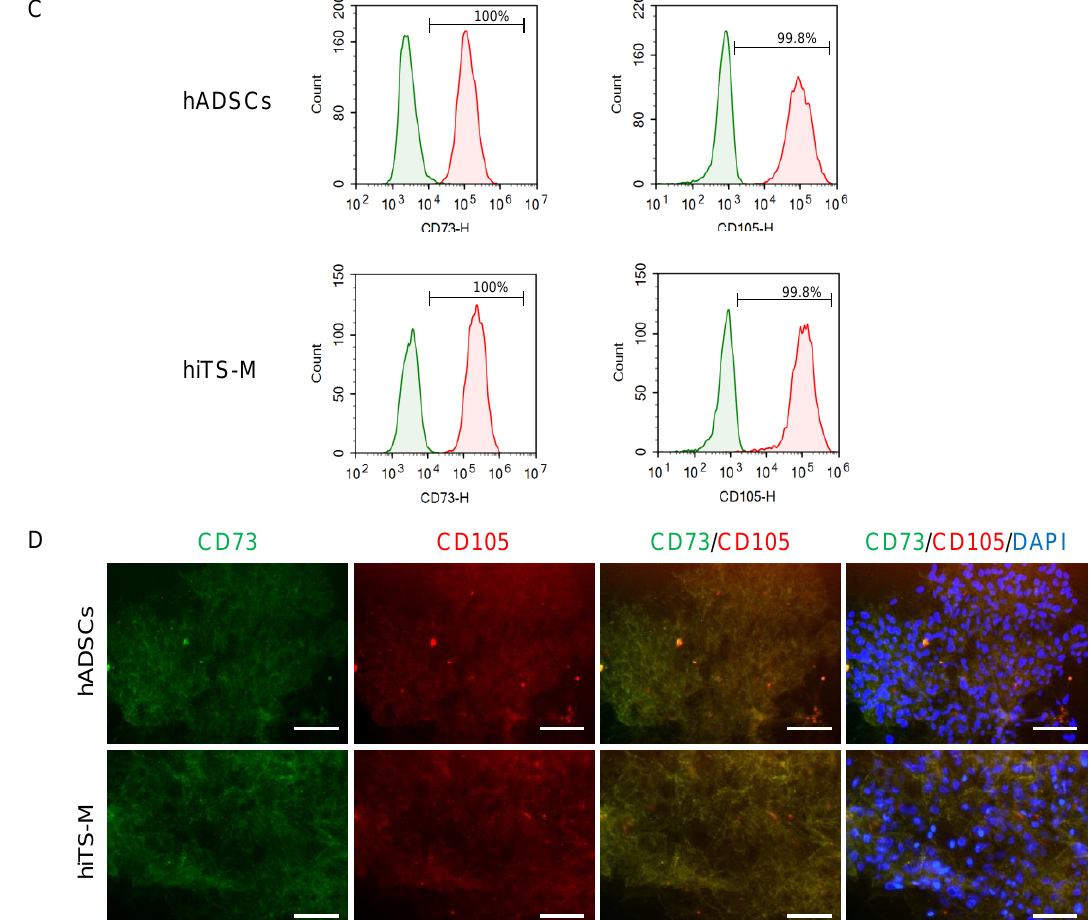
Figure 3. Genes and proteins expressed in hiTS-M cells. ( A ) qRT-PCR analysis of expression of genes encoding cell surface markers of hiTS-M cells. hADSCs were used as a control. ( B ) qRT-PCR analysis of expression of marker genes encoding growth factors produced by hiTS-M cells. hADSCs were used as a control. hiTS-M cells (passage 14 + 7) and hADSCs (passage 7) were used. Data are expressed as mRNA-to- GAPDH mRNA ratio, with the ratio of control cells arbitrarily defined as at one ( n = 3). Error bars represent the standard error. * p < 0.01. ( C ) Flow cytometric analysis of CD73 and CD105. hiTS-M cells (passage 14 + 7) and hADSCs (passage 7) were analyzed. ( D ) Immunofluorescence of CD73 and CD105 in hADSCs and hiTS-M cells. Scale bars = 100 µ